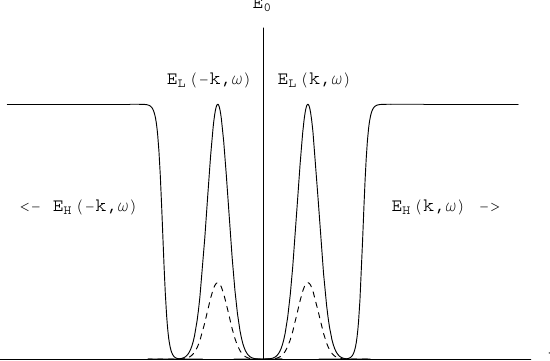
Fig. 8. A schematic representation of the scattered electric field Fig.8 spectrum in the broad-band case. The continuous curve represents the electric field and the dashed curve represents the striation spec- trum. Subscript ‘ L ’ indicates broad-band first order wavenumbers and ‘ H ’ indicates all higher